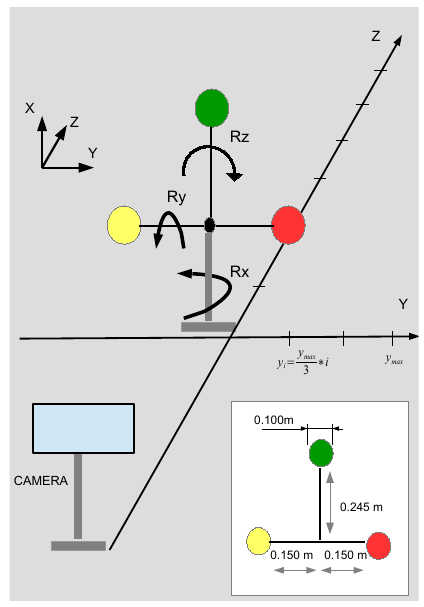
Figure 21. Experimental procedure for a characterization of the developed